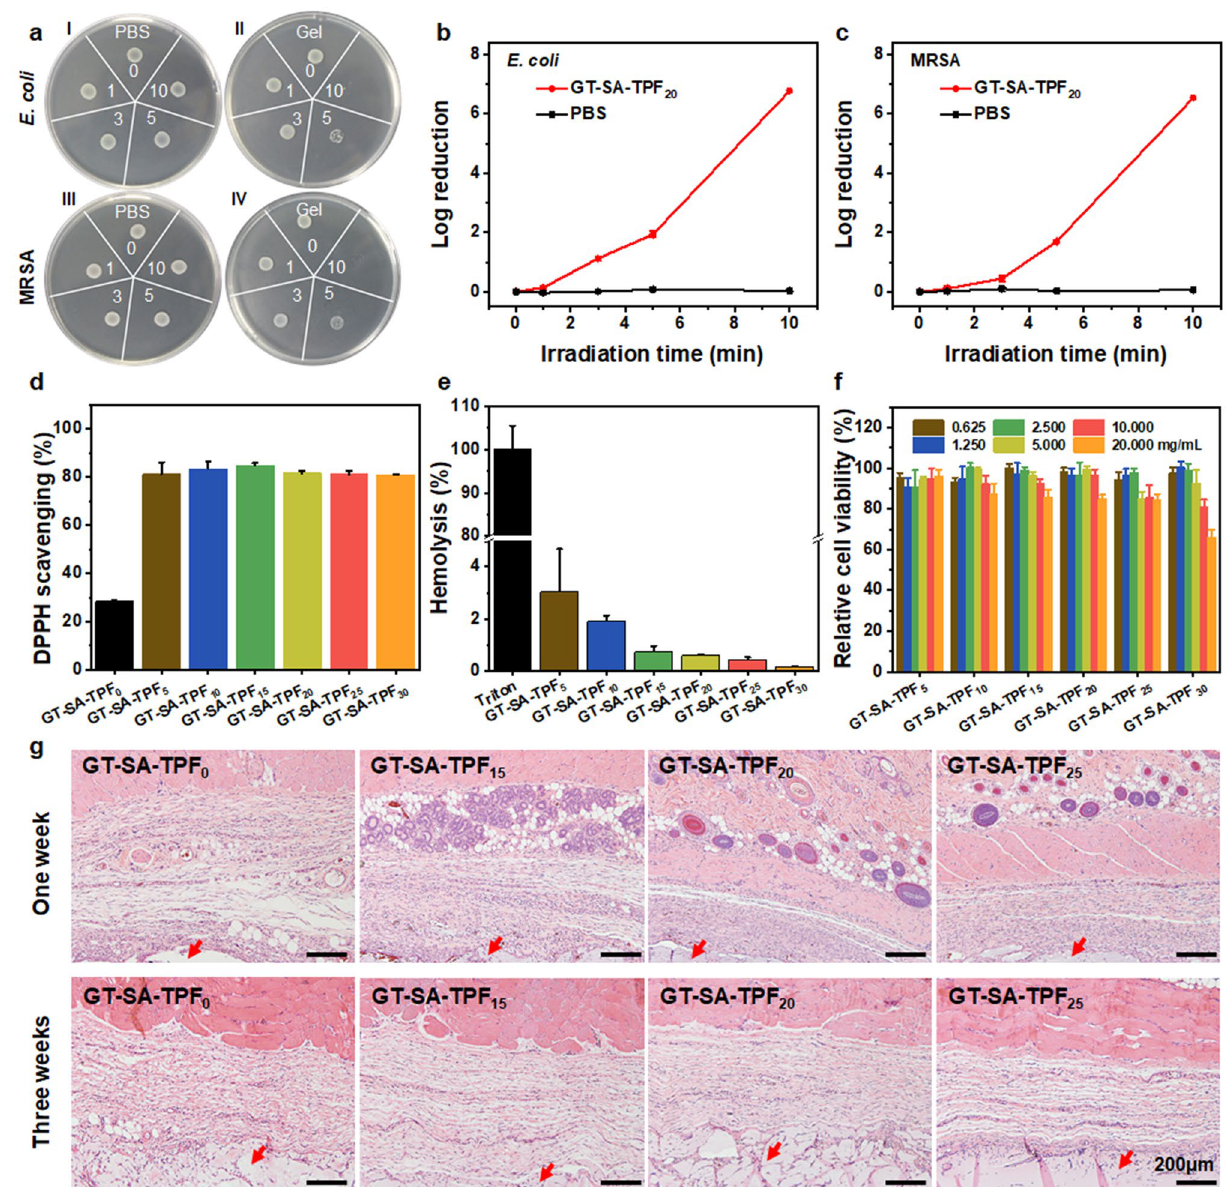
Fig. 4 Antibacterial activity, antioxidation and biocompatibility of the hydrogels. a Images of the survival E. coli treated by PBS (I) and hydro- gel (II) under NIR irradiation for different time. Images of the survival MRSA treated by PBS (III) and hydrogel (IV) under NIR irradiation for different time. The quantitative results of the antibacterial effect against b E. coli and c MRSA. d DPPH scavenging capacity and e hemocompat- ibility of the hydrogel samples. f Relative viability of L929 cells after incubated with leaching solutions of different samples at varied concentra- tion. g H&E staining images of the skin tissues after subcutaneously implanted with different hydrogel samples for one and three weeks. Arrow: the site of the